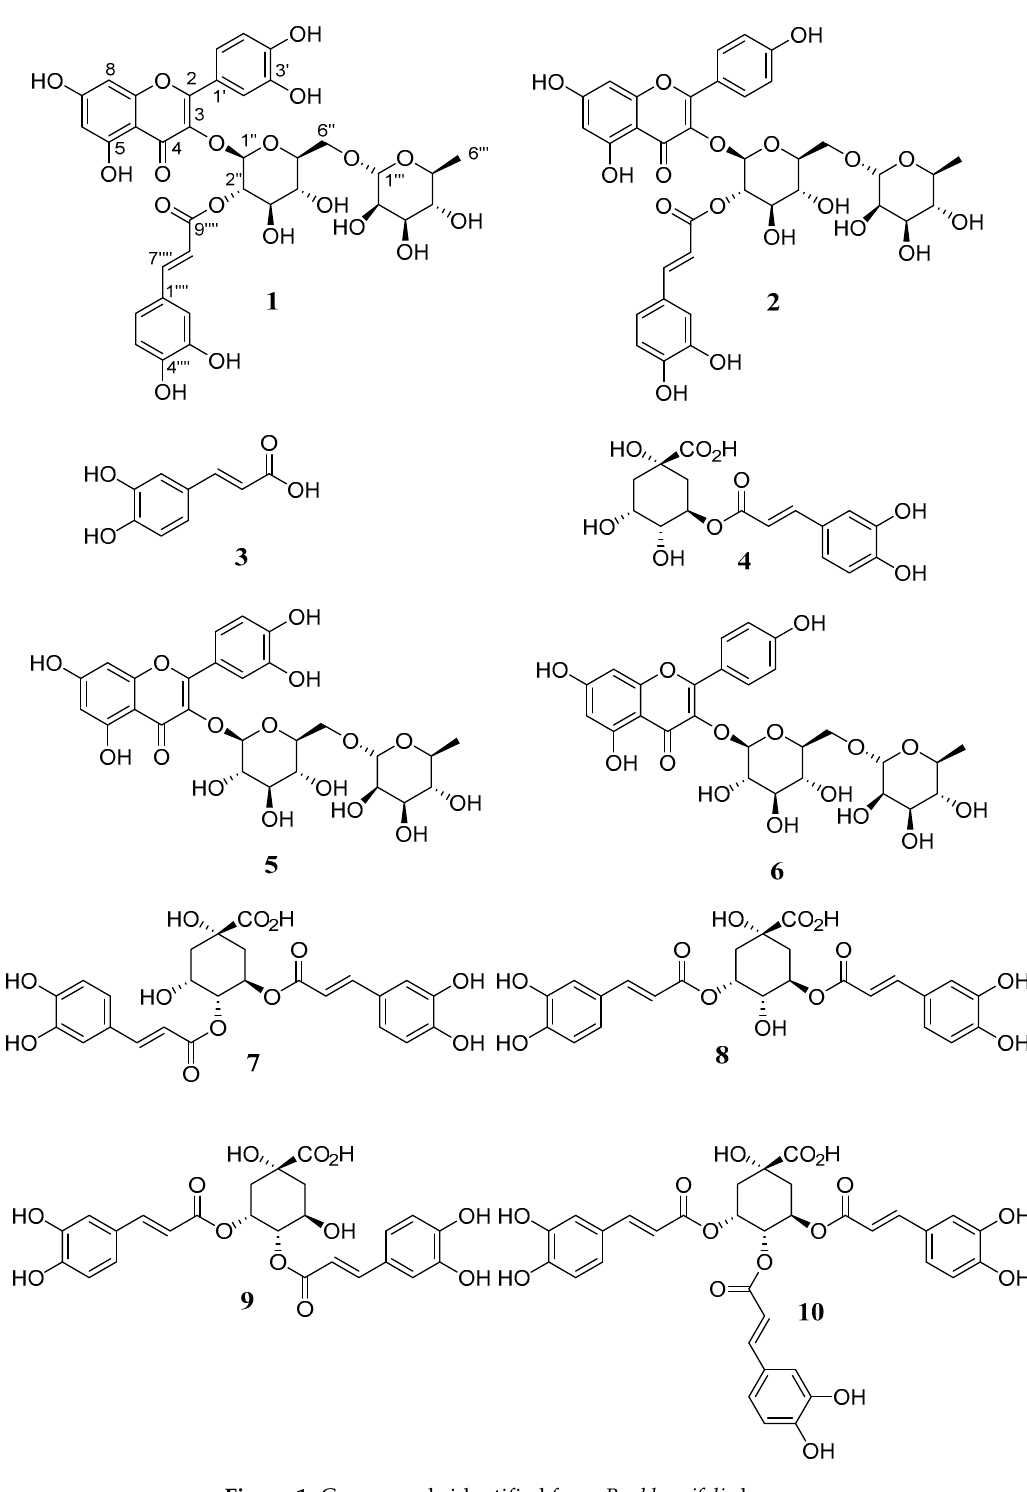
Figure 1. Compounds identified from B. oblongifolia leaves.